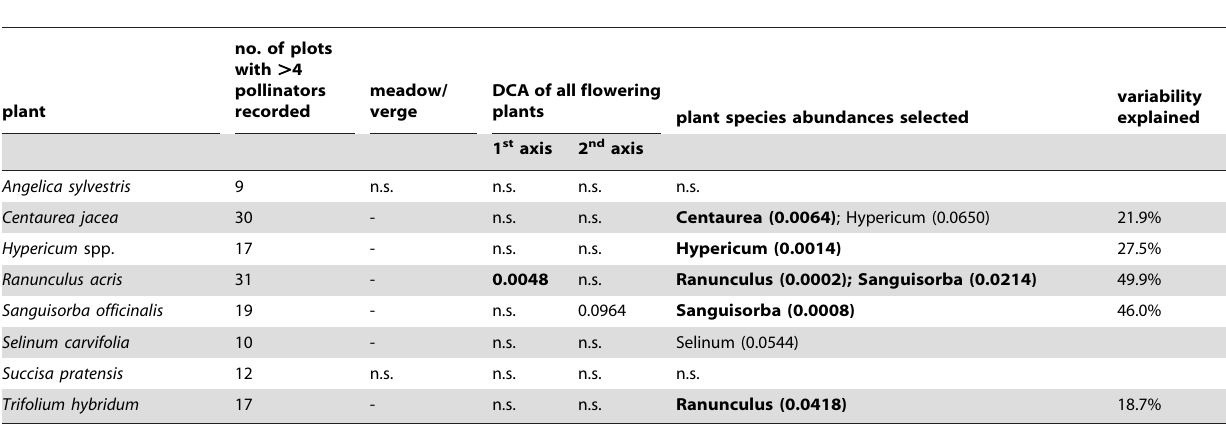
Table 2. Results of the multivariate analyses (RDA with forward selection) of interdependence between plant pollinator densities at each given